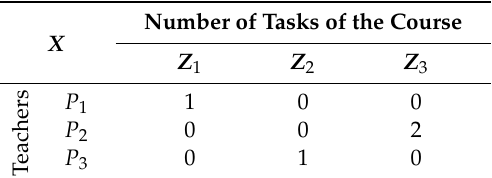
Table 2. A permissible teacher allocation, X .